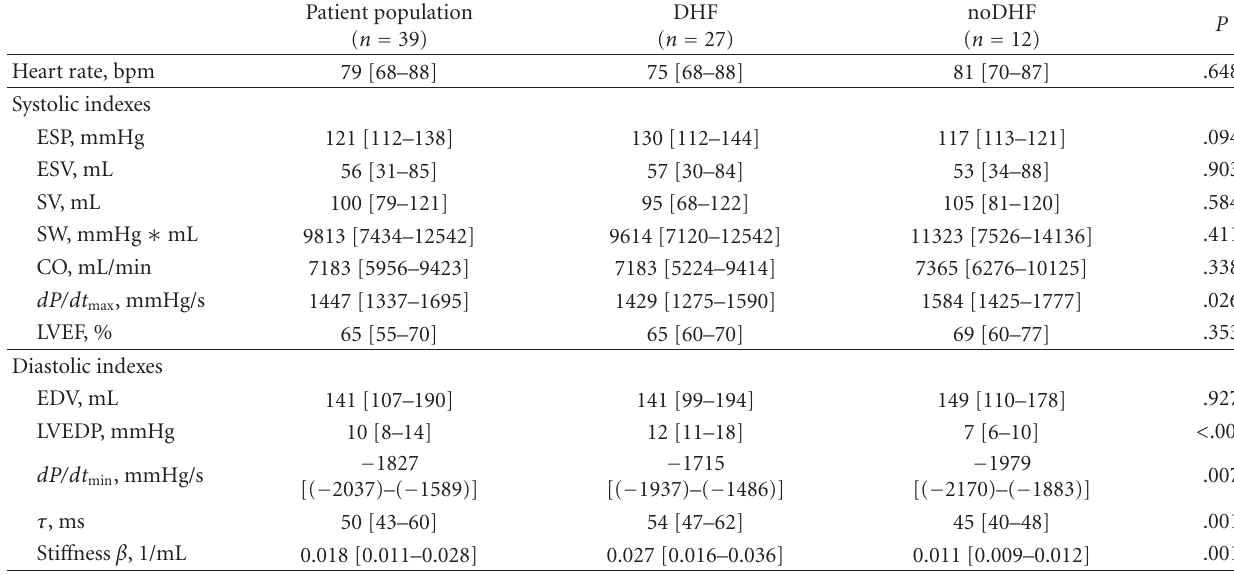
Table 2: PV measurements by Conductance Catheter Method (variable expressed as median [25%–75% quartile]).